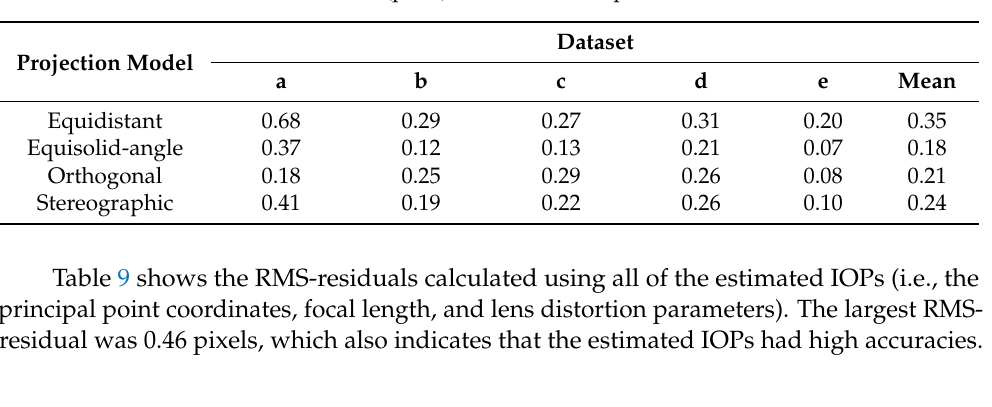
Table 8. RMSE value of lens distortion (pixel) in simulation